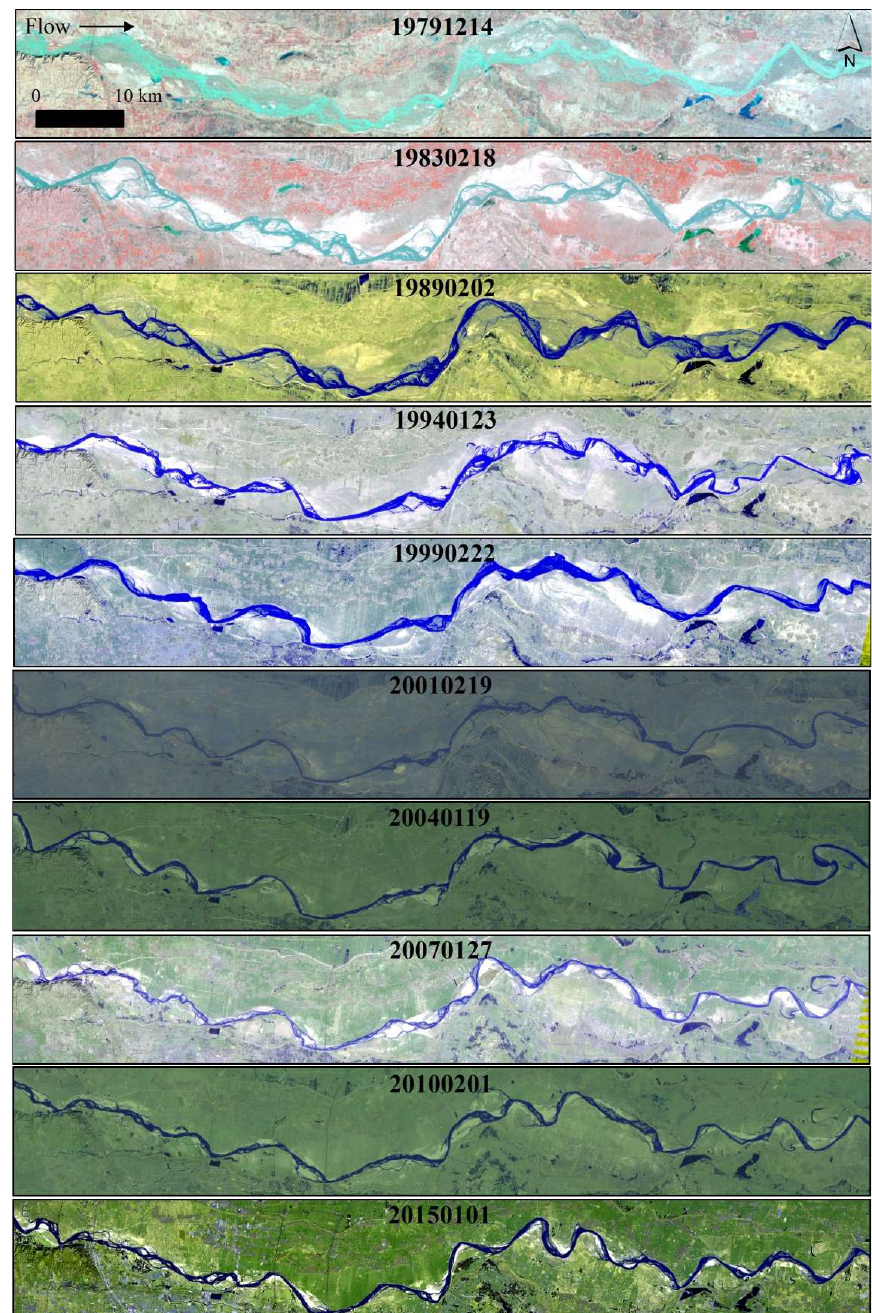
Figure 3. Remote sensing images of the study reach with a false color composite taken from 1979 to 2015.